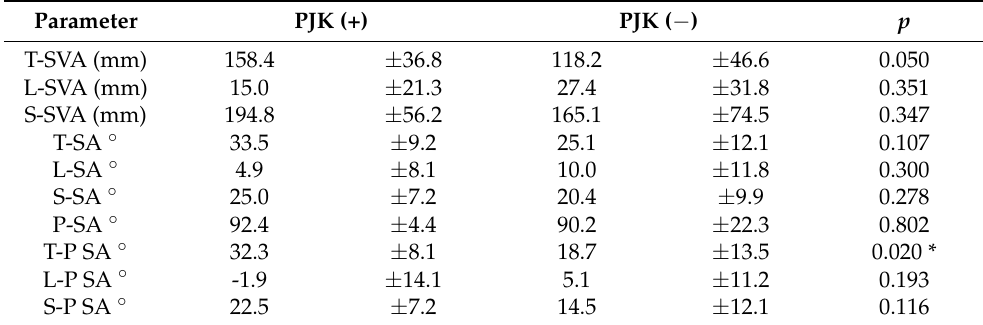
Table 4. Dynamic sagittal parameters between each group.